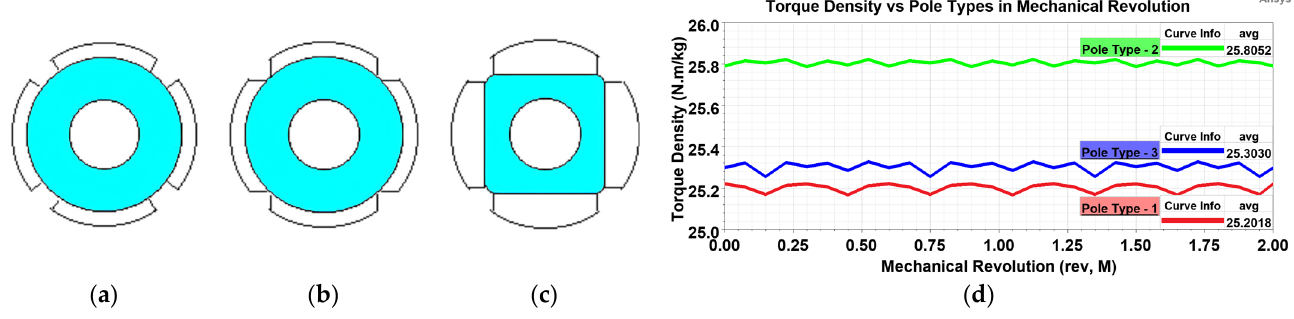
Figure 13. Pole types versus: ( a ) Type-1; ( b ) Type-2; ( c ) Type-3; ( d ) Torque density in rev,M.